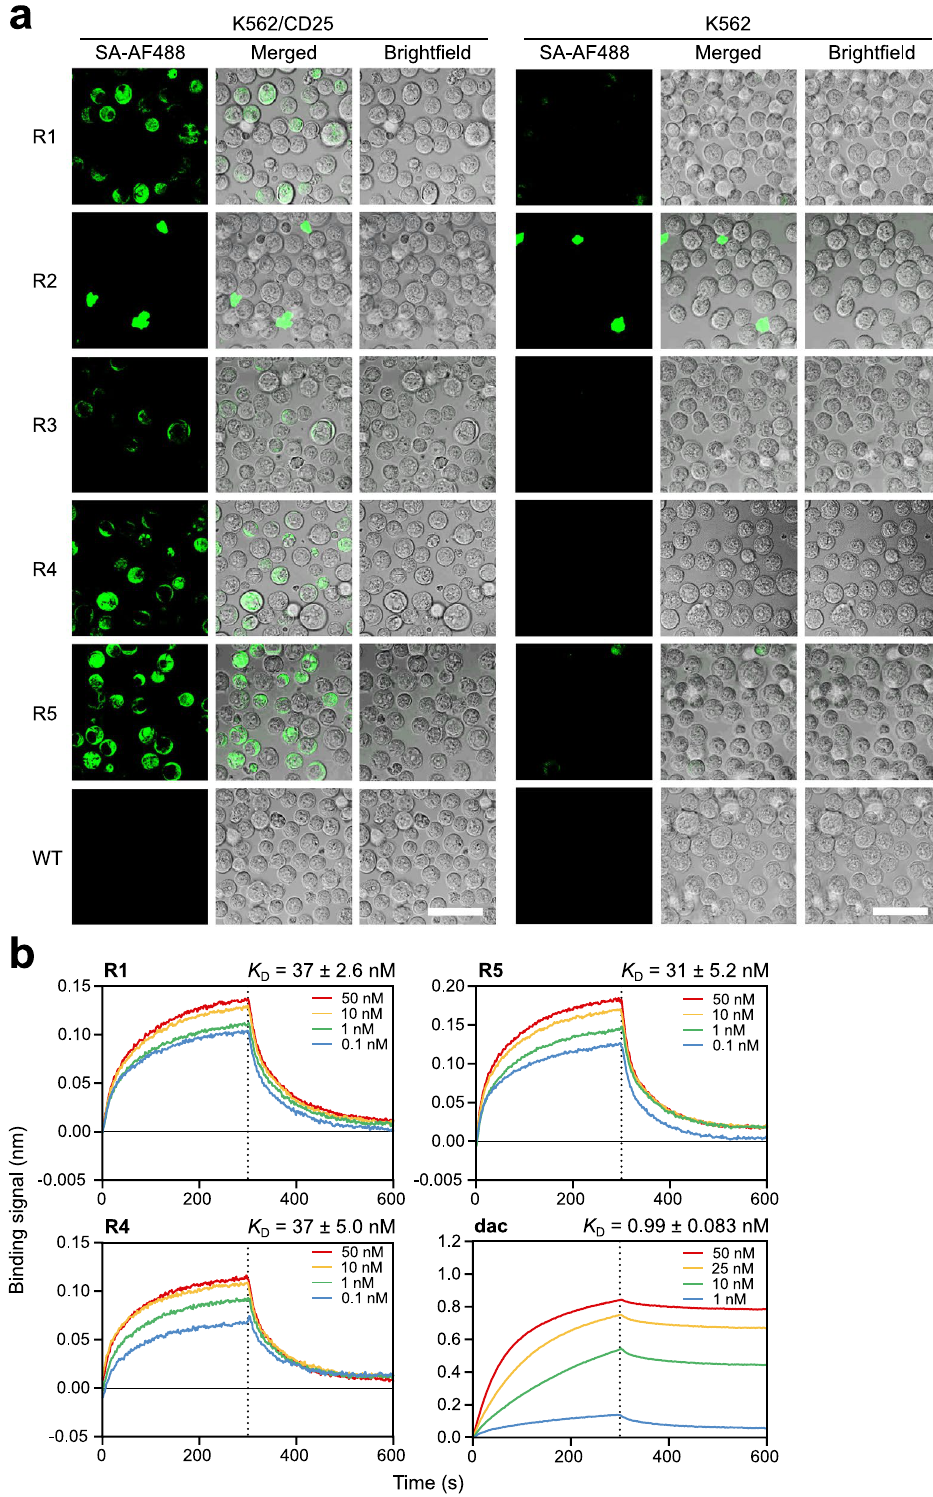
Figure 5. Characterization of Zif-FLAP binding to CD25. ( a ) Specific binding of Zif-FLAP candidates to K562/ CD25 cells. Binding of the five peptides to fixed K562/CD25 cells was detected using SA-AF488 (green). Scale bar = 50 μm. ( b ) Binding of Zif-FLAPs and daclizumab to CD25-Fc as monitored by BLI. Biotinylated Zif- FLAPs or daclizumab (dac) was immobilized on streptavidin sensors and exposed to various concentrations of CD25-Fc. Representative sensorgrams with corresponding K D ± SEM values calculated from three separate experiments are